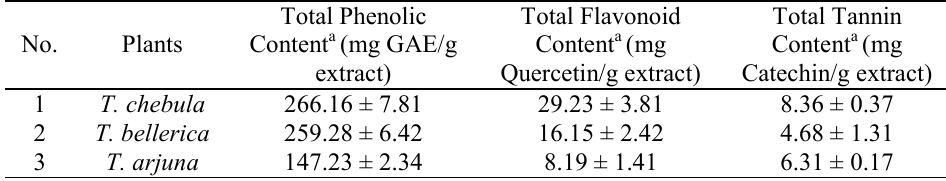
Table 1. Total phenolic, flavonoid, and tannin content in methanolic extracts of Terminalia chebula, T. bellerica , and T. arjuna